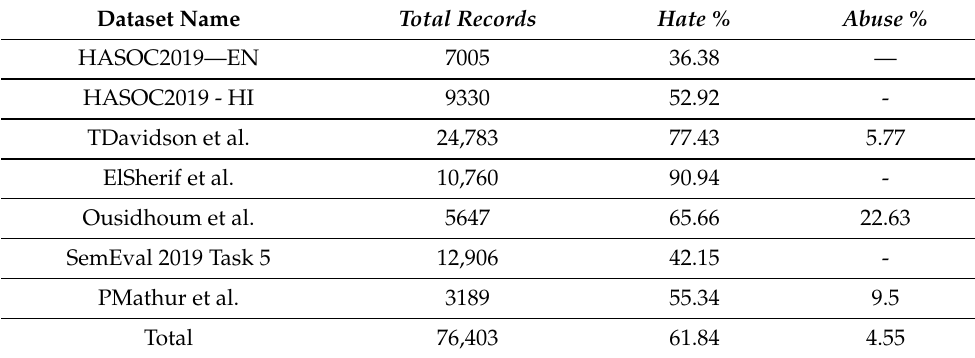
Table 2. Datasets hate